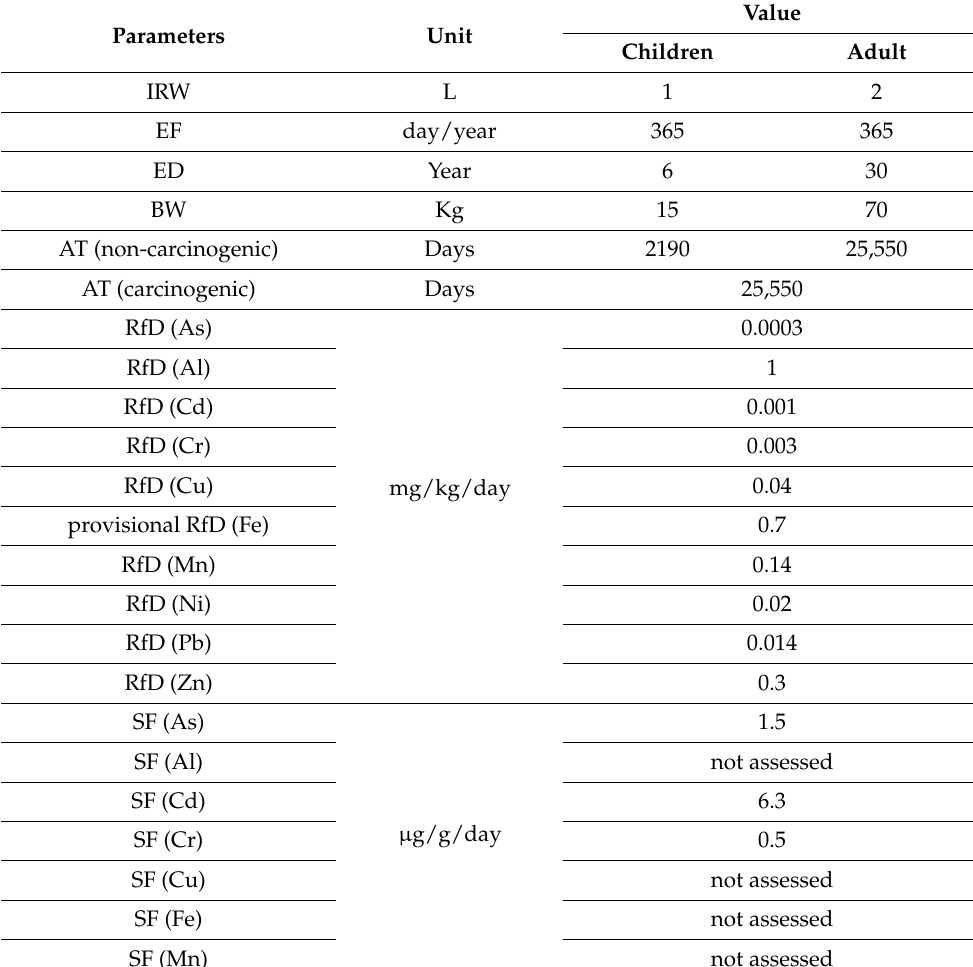
Table 4. Parameters used to estimate exposure assessment of analysed elements in water sam- ples